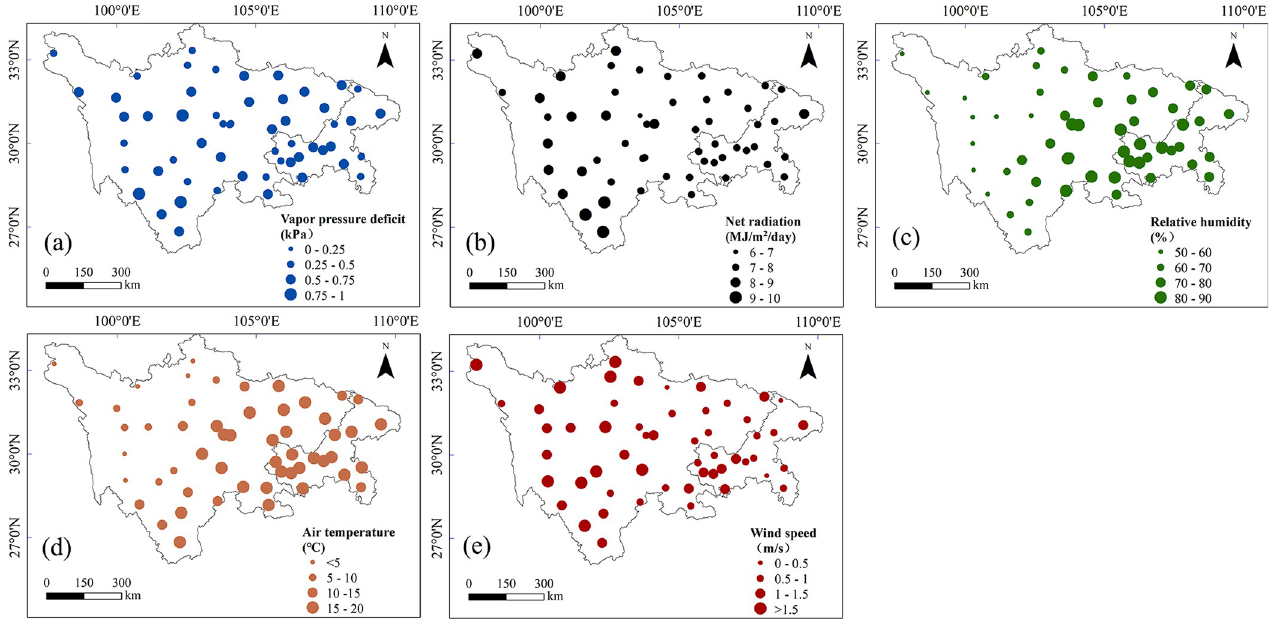
Fig 4. Mean annual values of five basic meteorological variables ((a) vapor pressure deficit, (b) net radiation, (c) relative humidity, (d) air temperature and (e) wind speed) at each station in the Sichuan-Chongqing region from 1970 to 2020. Republished under a CC BY license, with permission from the China Meteorological Data Service Center, original copyright